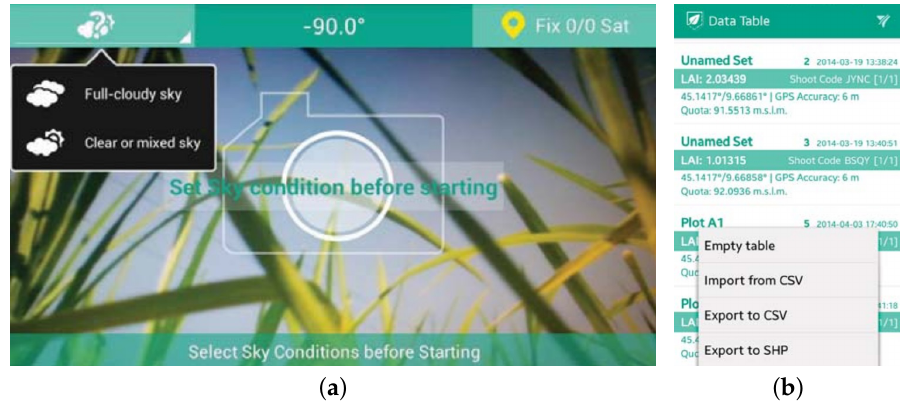
Figure 24. PocketLAI: ( a ) Measuring mode interface; ( b ) Data table with leaf area index (LAI) readings and related metadata, as well as import/export options.